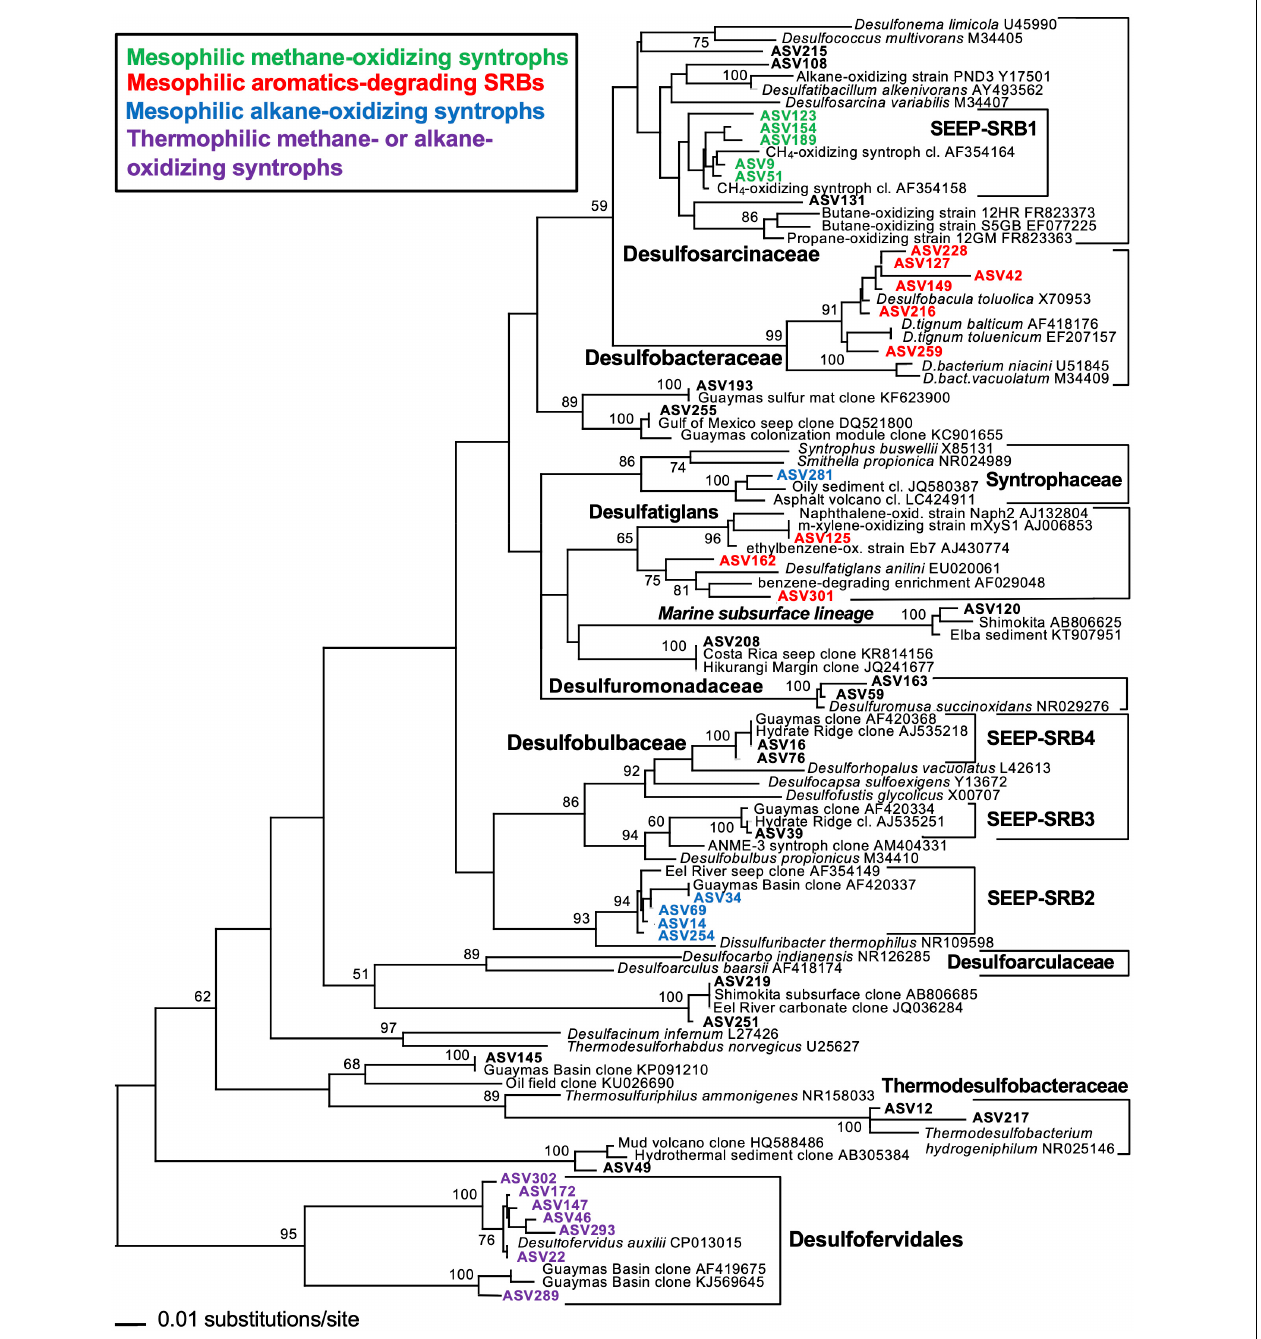
FIGURE 2 | 16S rRNA gene distance phylogeny of frequently occurring deltaproteobacterial ASV sequences according to Escherichia coli nucleotide positions 515–926 using forward primer 515F-Y and reverse primer 926R (Ramírez et al., 2021) in hydrothermal sediments of Guaymas Basin, southern axial valley. The branching pattern was checked by 1000 NJ Bootstrap iterations. The tree was rooted with the Desulfofervidales as outgroup. Modified by inferred substrate usage from Ramírez et al. (2021) (Supplements).